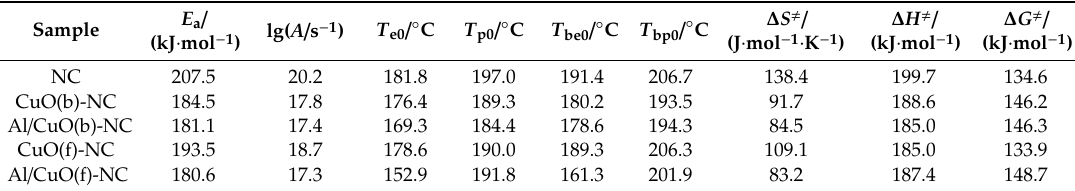
Table 3. Calculated values of kinetic parameters of decomposition reaction for NC, CuO(b)-NC, Al / CuO(b)-NC, CuO(f)-NC, and Al / CuO(f)-NC.